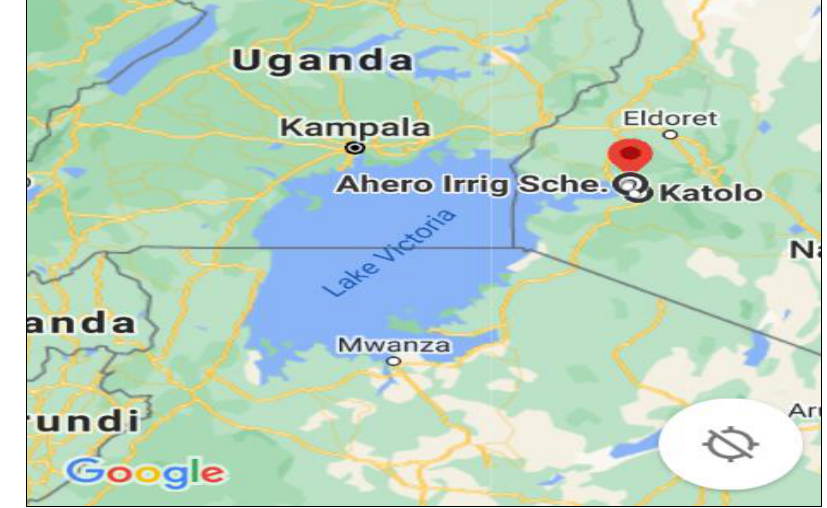
Figure 1: Route Map of Ahero irrigation